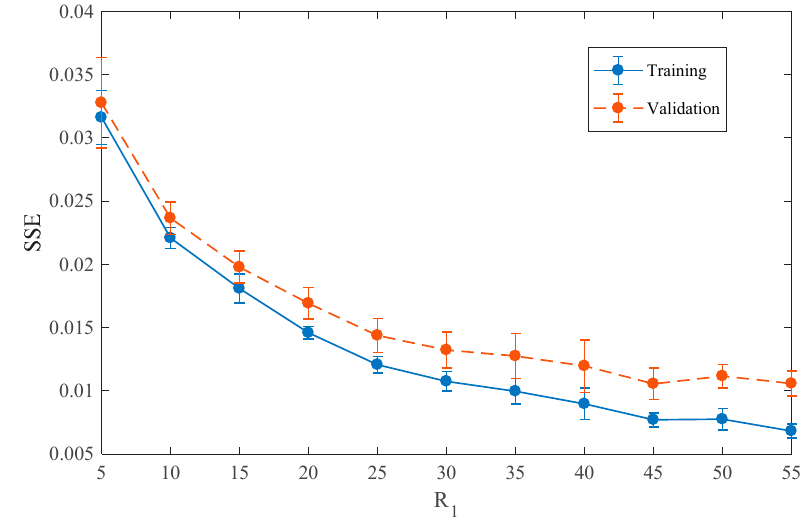
Figure A1. Normalized mean sum of squared error (SSE) with respect to the number of neurons in the hidden layer (R1).